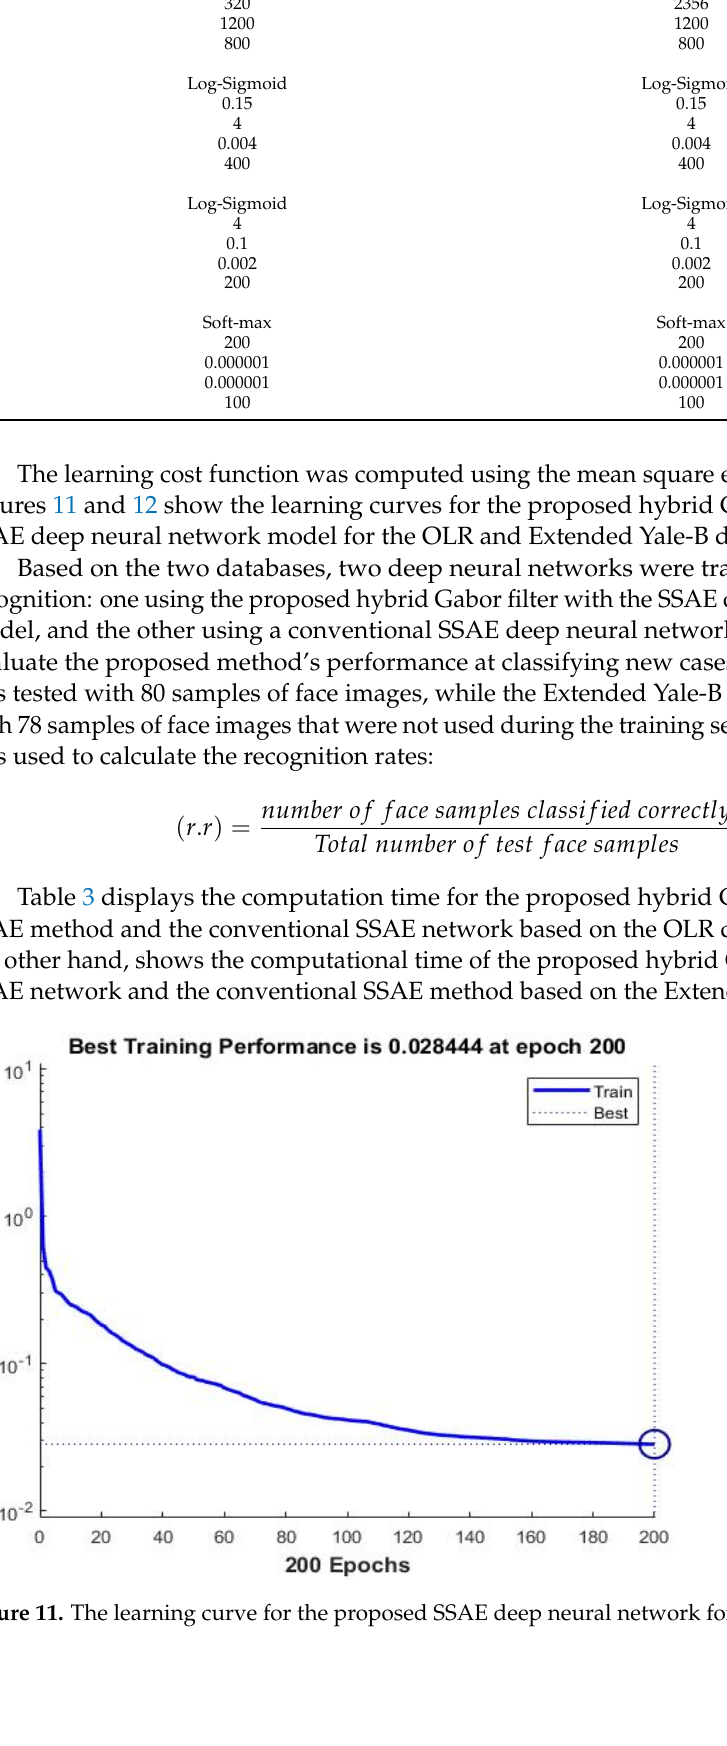
Figure 12. The learning curve for the proposed SSAE deep neural network for the Extended Yale-B database. Table 3. Execution time computed for the OLR database. SN of Images